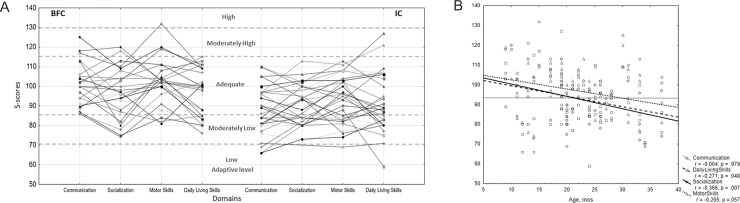
SS-score profiles for the VABS adaptive behavior domains in the IC and BFC groups of children (A); bands of the scores corresponding to a qualitative description of the level of adaptive behavior are marked by dotted lines. Correlations between the VABS domain SS-scores and children's age (B), estimated for the combined sample of 58 children.